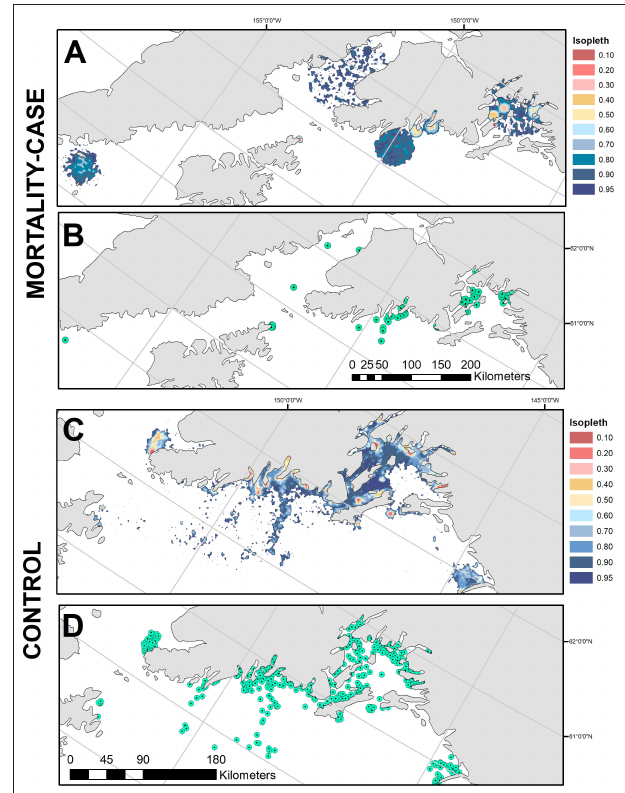
FIGURE 3 | Habitat variables included as predictors of predation in our study area, the Gulf of Alaska: (A) distance to Steller sea lion haulout or rookery (km; haulouts/rookeries denoted as black points; Fritz et al., 2015), (B) depth (m), and (C) slope derived from bathymetry (Lim et al., 2011). here, the time between mortality and first computed locations obtained via satellite uplinks ranged from 3 to 120 h ( Table 1 ).